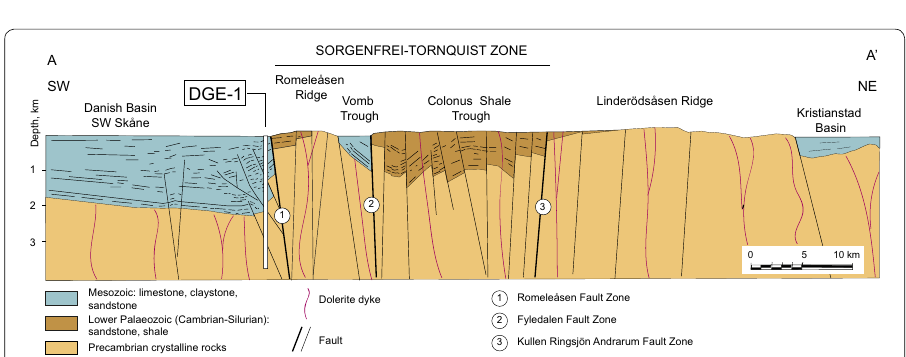
Fig. 2 Geological cross section of Skåne illustrating the major structural elements associated with the Sorgenfrei–Tornquist Zone and the location of the DGE‑1 well. The location of the cross section is shown in Fig.